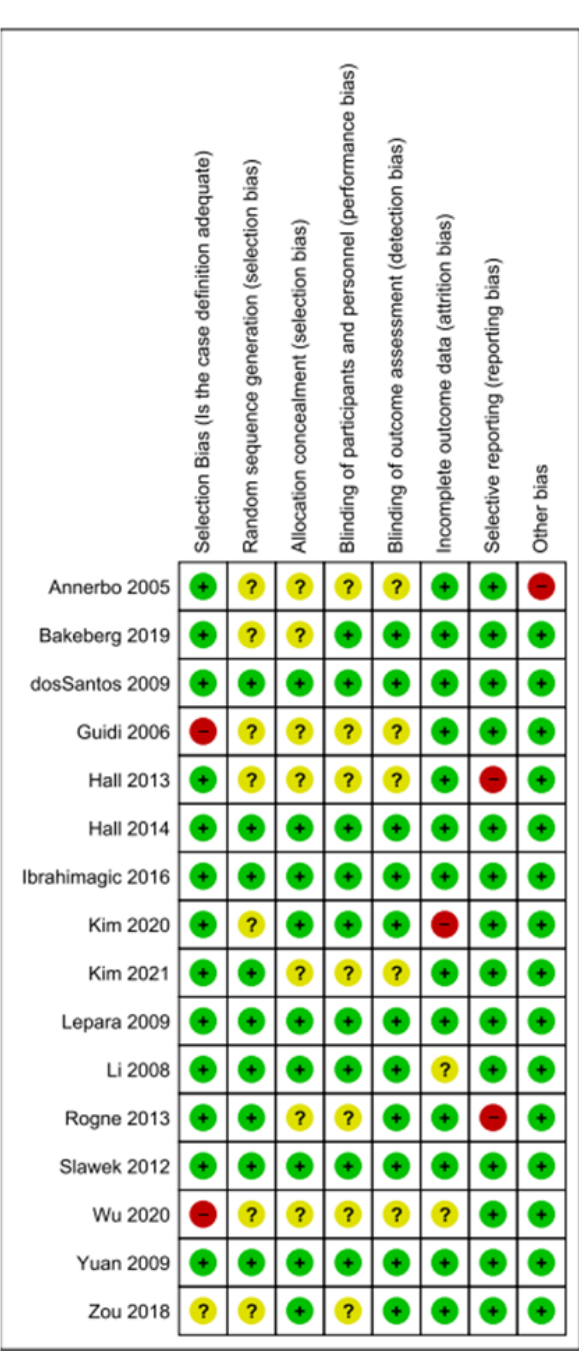
Figure 4. Summary of risk bias assessment for each study. Studies are indicated by the last name of the first author and year of publication [4,10,12,22–34]. Seven risk of bias domains were assessed, including selection bias, random sequence generation, allocation concealment, blinding of participants and personnel, blinding of outcome assessment, incomplete outcome data, and selective reporting; green = low risk of bias, yellow = unclear risk of bias, red = high risk of bias.